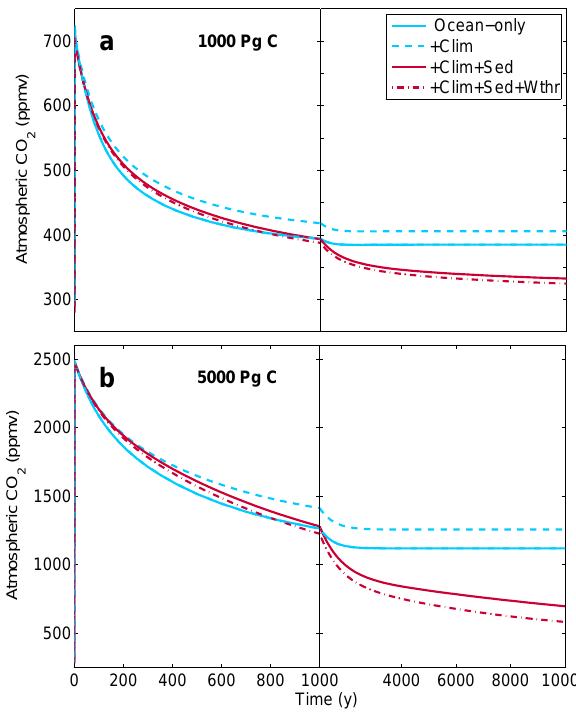
Fig. 8. LOSCAR simulations of the long tail of the lifetime of fossil fuel CO 2 (cf. Archer et al., 2009). (a) Simulated atmospheric CO 2 concentrations in response to a 1000 Pg C pulse, (b) 5000 Pg C pulse. “Ocean- only” runs include ocean CO 2 uptake only (sediments off, weathering feedback off). “+Clim” runs include an additional temperature feedback of 3 ◦ C per CO 2 doubling (see Sect. 7.3). “+Clim+Sed” runs include the temperatureandsedimentfeedback(weatheringfluxesareheldconstant). “+Clim+Sed+Wthr”runsincludethe temperature,sediment,andweatheringfeedback.